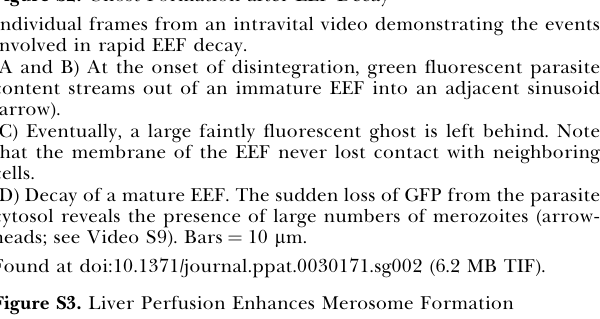
Figure S2. Ghost Formation after EEF Decay Individual frames from an intravital video demonstrating the events involved in rapid EEF decay. (A and B) At the onset of disintegration, green fluorescent parasite content streams out of an immature EEF into an adjacent sinusoid (arrow). (C) Eventually, a large faintly fluorescent ghost is left behind. Note that the membrane of the EEF never lost contact with neighboring cells. (D) Decay of a mature EEF. The sudden loss of GFP from the parasite cytosol reveals the presence of large numbers of merozoites (arrow- heads; see Video S9). Bars ¼ 10 l m. Figure S3. Liver Perfusion Enhances Merosome Formation (A) Ex vivo confocal analysis of a non-perfused mouse liver. The presence of oversized PyGFP merosomes suggests that the absence of blood flow prevented them from subdividing into smaller units. Bar ¼ 20 l m. (B) Ex vivo confocal analysis of a perfused mouse liver. Merosomes extend over hundreds of micrometers from the EEF into various sinusoids indicating that liver perfusion augmented merosome budding and separation from the host cell. Bar ¼ 100 l m. Found at doi:10.1371/journal.ppat.0030171.sg003 (7.2 MB TIF). Table S1. Size and Merozoite Content of Plasmodium EEFs Comparison of the estimated numbers of merozoites produced by various Plasmodium species in different hosts with the calculated data obtained from P. yoelii –infected mice presented in this paper. Table S2. Merozoite Content of P. yoelii Merosomes and EEFs Merosomes were collected from the hepatic effluent. A subpopula- tion of small merosomes was used to measure the merosome diameter in relation to the merozoite content. An algorithm for optimal sphere packing (see Materials and Methods) was then used to calculate the effective merozoite diameter in these merosomes. This effective diameter (2.175 l m) was then entered into the same algorithm to determine the number of merozoites contained in the much larger EEFs in relation to their